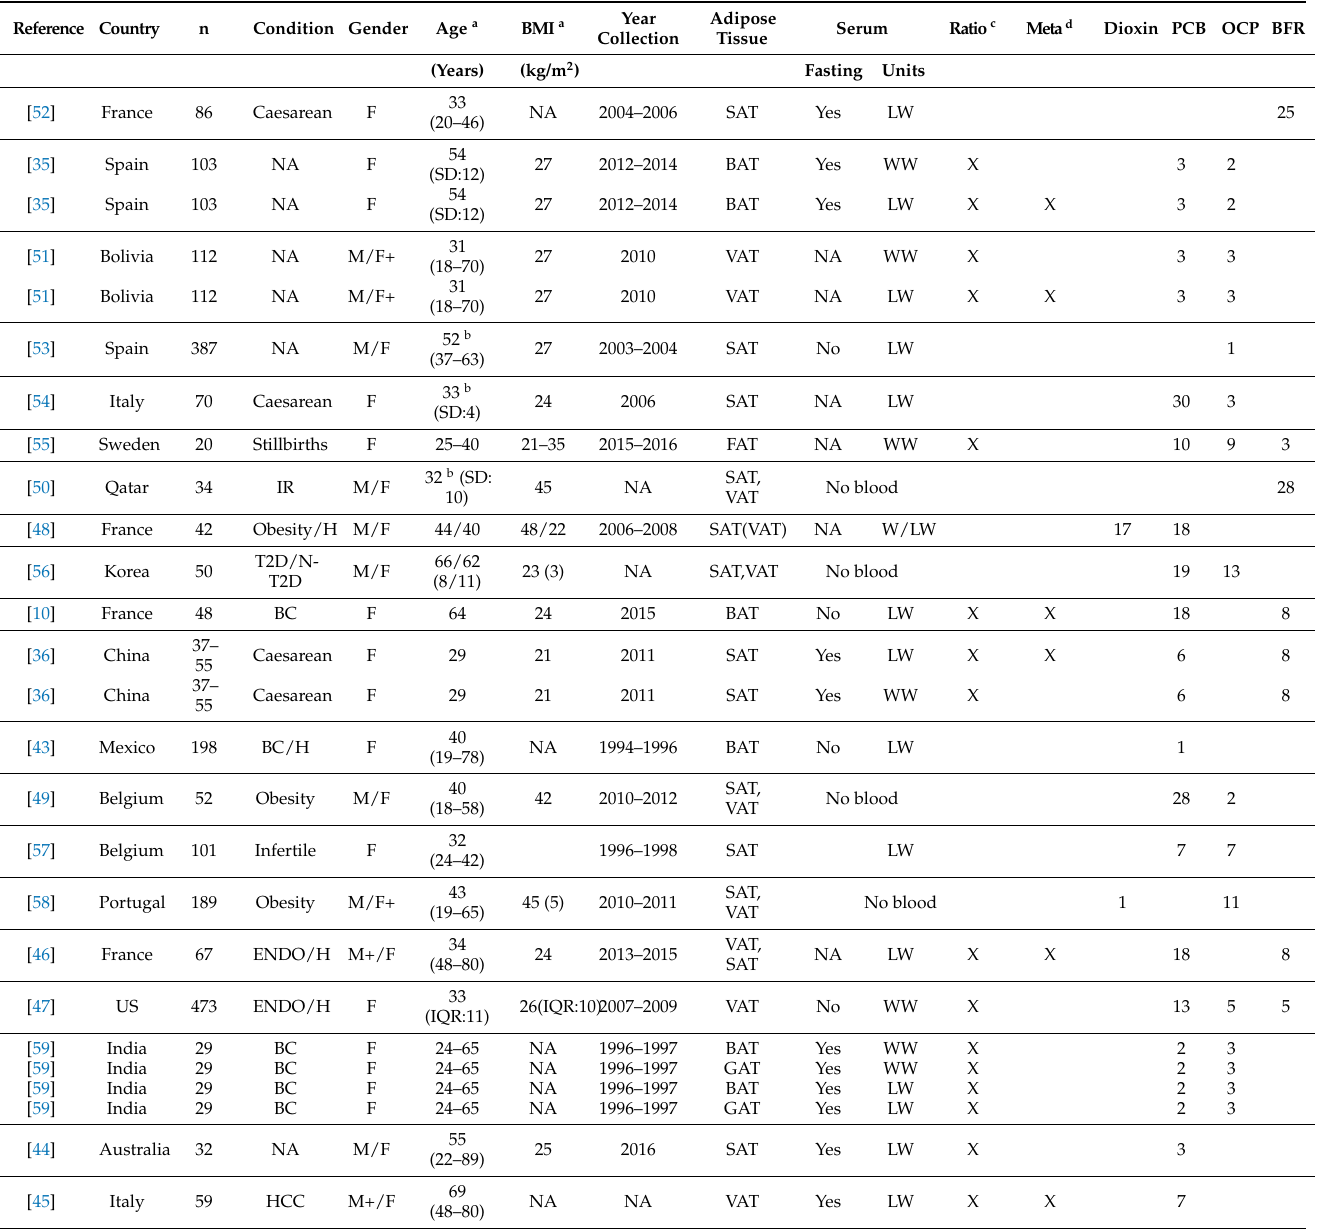
Table 3. Summary of study